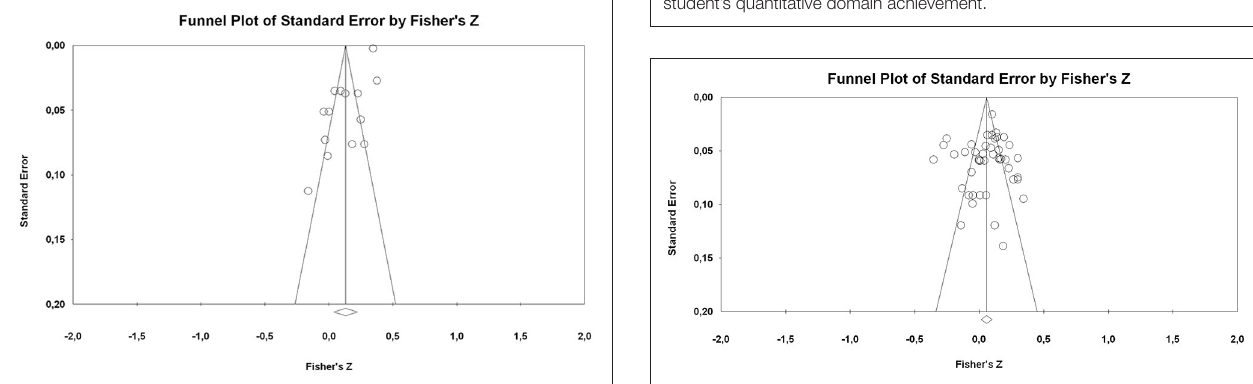
FIGURE 4 | Funnel plots of effect sizes of the correlation between ITI and student’s general assessment